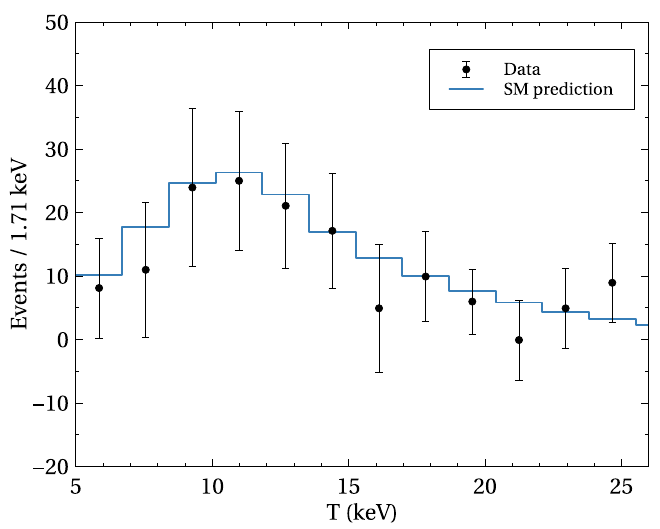
Figure 1 . Expected number of events for the CsI detector of the COHERENT collaboration against the nuclear recoil energy T . The solid blue line shows the expected events in the SM framework, while the black points correspond to the experimental measurements